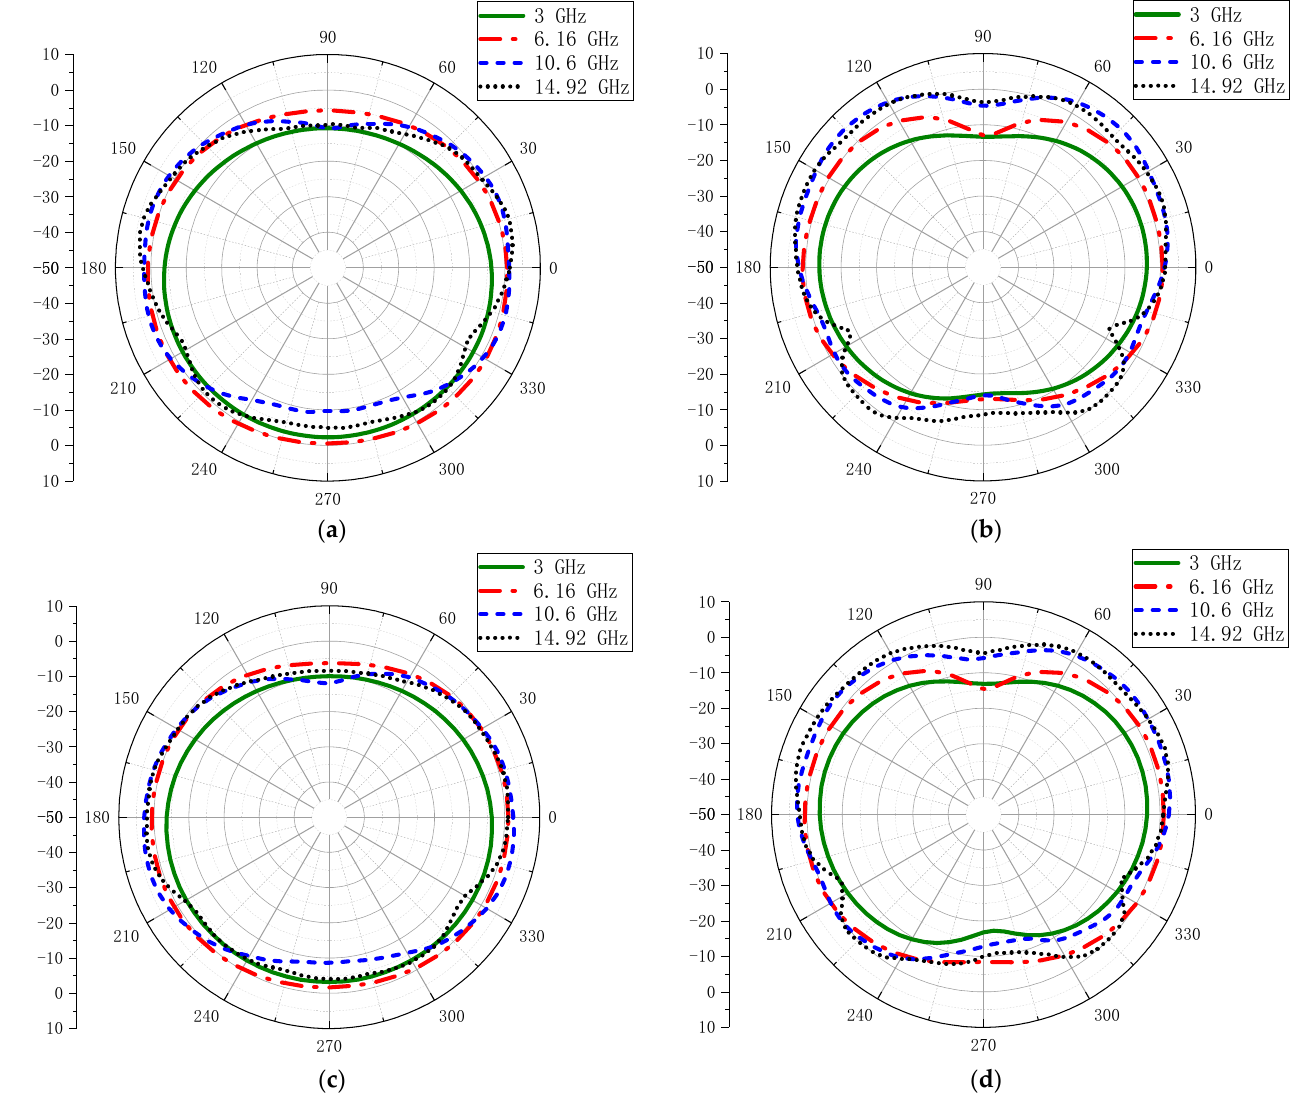
Figure 11. Simulated radiation pattern of proposed MIMO antenna in: ( a ) E-plane (without strips); ( b ) H-plane (without strips); ( c ) E-plane (with strips); ( d ) H-plane (with strips).